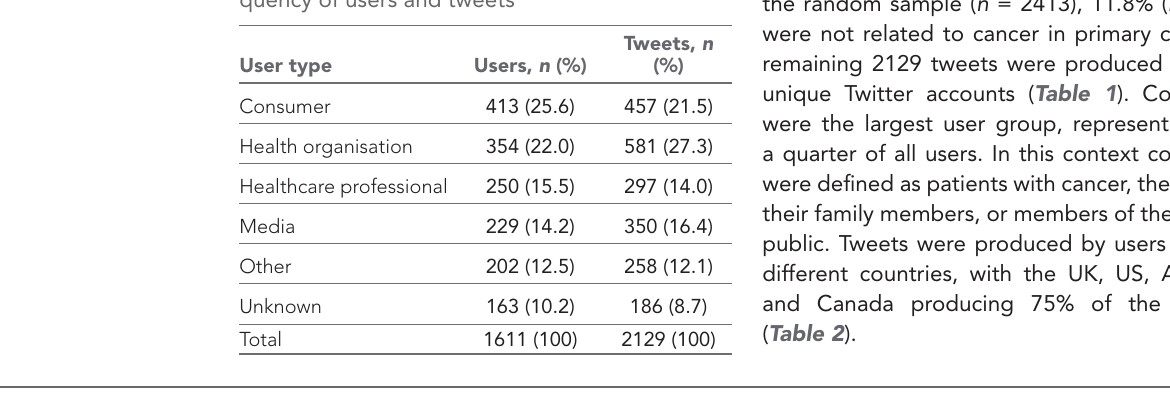
Table 1 Summary of the type of user and fre-